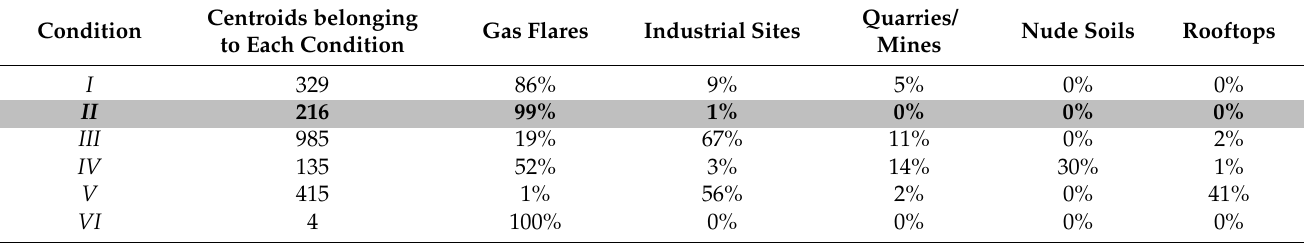
Table 2. HP conditions for each identified category (see Figure